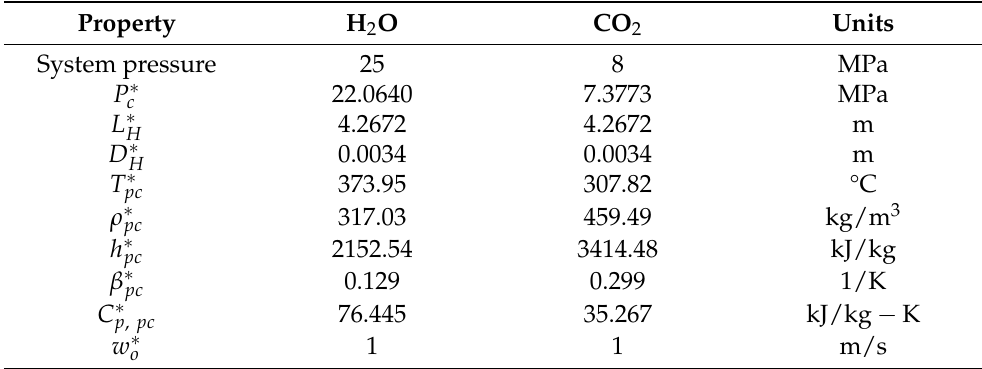
Table 1. The geometrical and operational parametric values that are assumed in the present study [9,29].